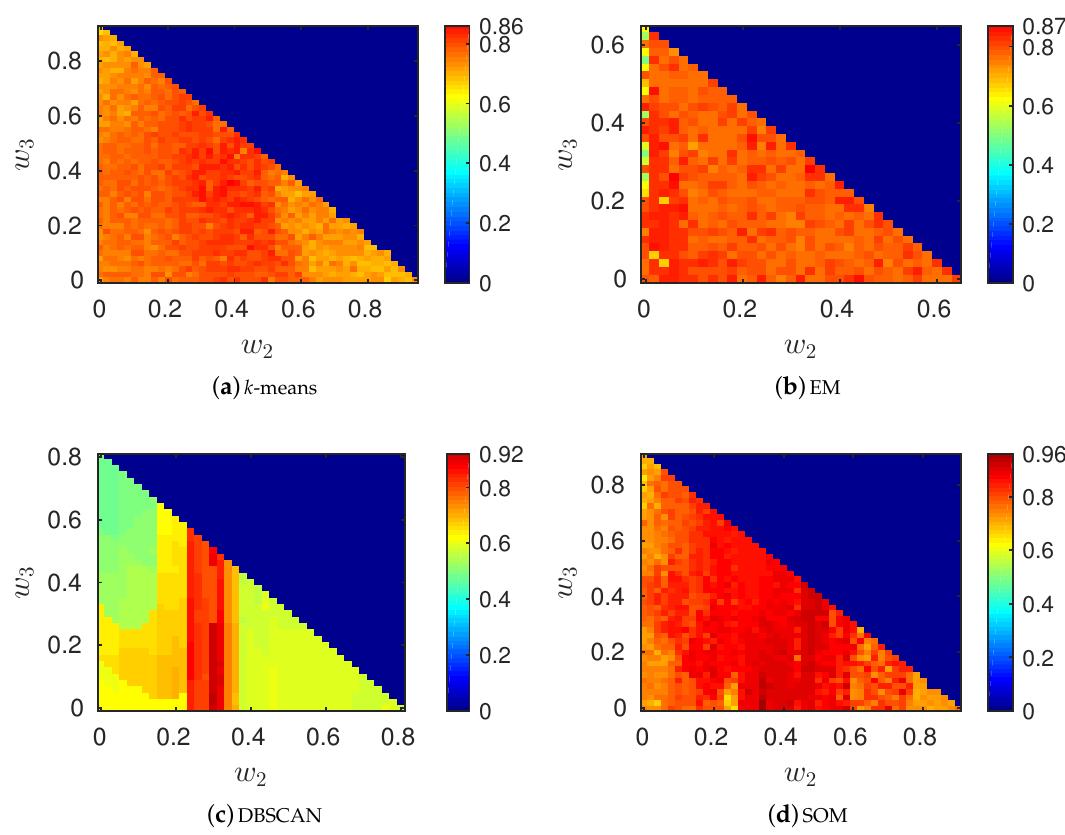
Figure 9. Optimal weights. In ( a ), the weights are w 1 = 0.06, w 2 , w 3 ∈ [ 0,0.94 ] ; in ( b ) the weights are w 1 = 0.35, w 2 , w 3 ∈ [ 0,0.65 ] ; in ( c ), the weights are w 1 = 0.2, w 2 , w 3 ∈ [ 0,0.8 ] ; in ( d ), the weights are w 1 = 0.1, w 2 , w 3 ∈ [ 0,0.9 ] . In the heat maps, the weighted F-measure is represented with a color. The weights above the main diagonal are indicated with a dark blue color and are infeasible, as their sum is greater than one. Feasible weights lie below the main diagonal, and dark red means F-measure =